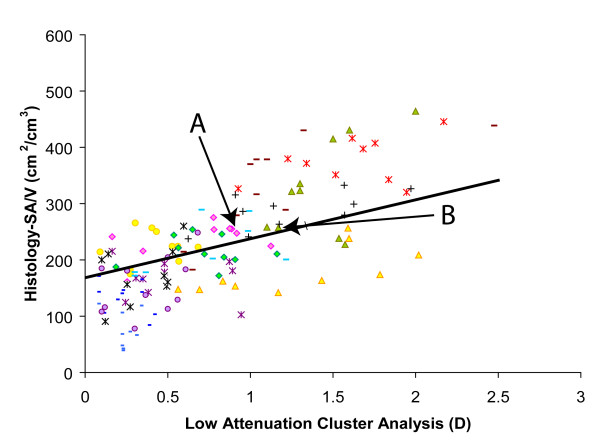
Association between the Histological SA/V and CT Cluster Analysis Value D. There is a significant association between the SA/V (cm2/cm3) measured histologically and the CT cluster analysis D value (r = 0.74, p < 0.0001). All subjects are shown using different symbols. Data point A and B have comparable value for SA/V and CT cluster analysis (sample A: SA/V = 247 cm2/cm3, D = 0.91; sample B: SA/V = 258 cm2/cm3, D = 1.17). A and B refer to the same samples in Figure 2, 3, and 5.